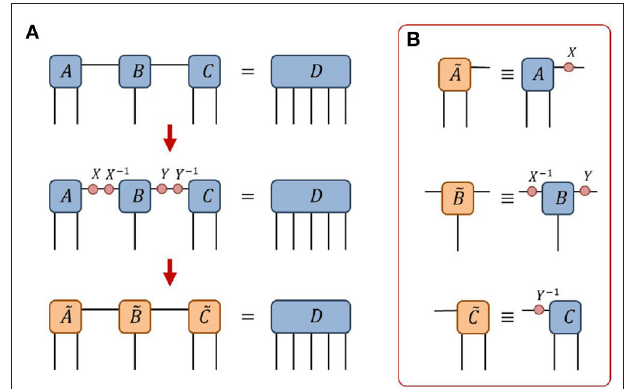
FIGURE 8 | (A) Given a network of three tensors { A , B , C } , one can introduce gauge change matrices X and Y (together with their inverses) on the internal indices of the network while leaving the final product D of the network unchanged. (B) Definitions of the new tensors {˜ A , ˜ B , ˜ C } after the change of